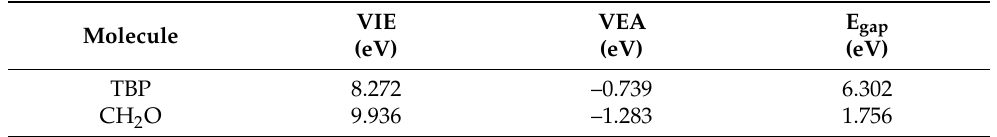
Table 1. Vertical ionization energy (VIE), vertical electron affinity (VEA) and HOMO–LUMO energy gap for TBP and CH 2 O